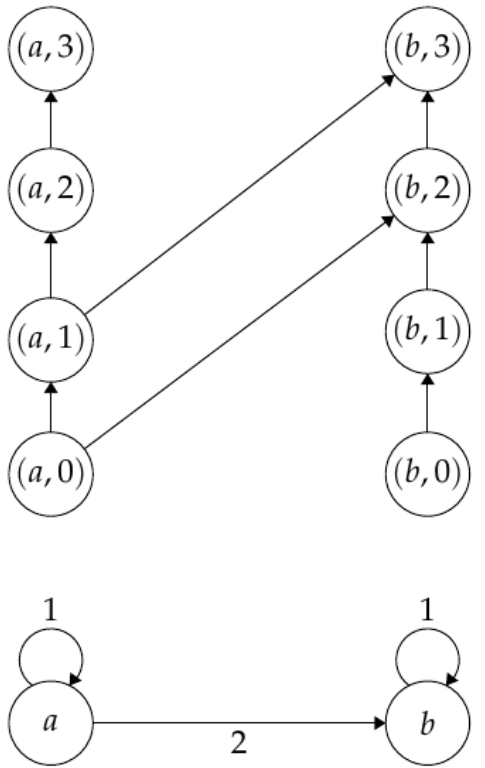
Figure 1. In the bottom part of the figure, a simple graph A is shown. In the top part, the correspond- ing base diagram B is